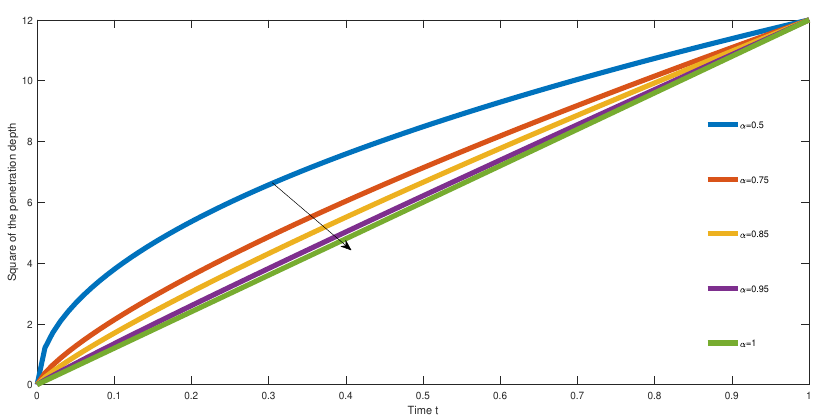
Figure 4. Profiles with different values of the fractional order.